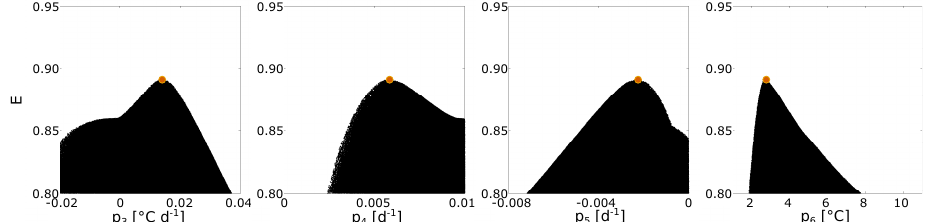
Fig. 6. Dotty plots of efficiency indexes ( E ) for the four-parameter model during the calibration period 1985–2002 (NDBC simulation). Highest efficiency is presented with an orange dot.